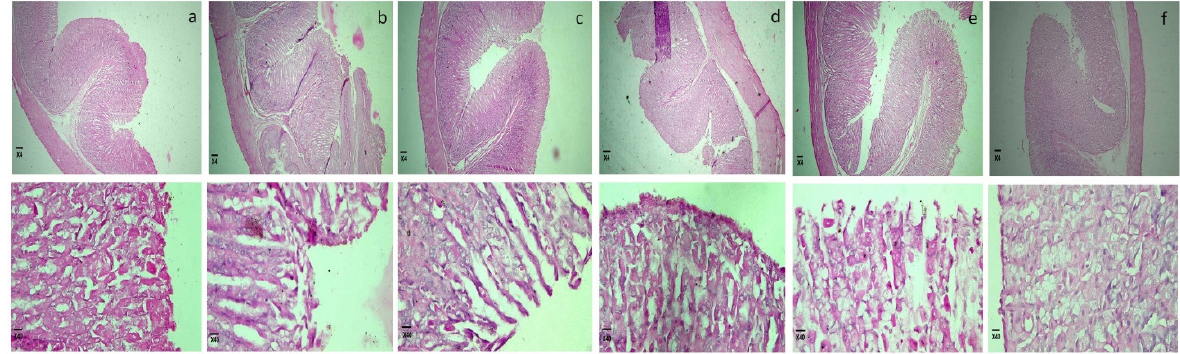
Figure 9. Histological micrographs of ( a ) control group, ( b ) group treated with pure flurbiprofen, ( c ) group treated with S1, ( d ) group treated with S6, ( e ) group treated with S7, ( f ) group treated with S12 at 4× and 40×.